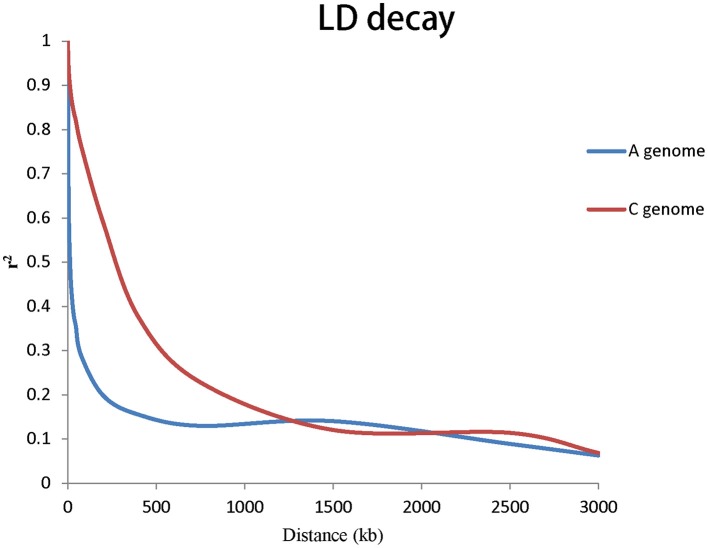
Genome-wide LD decay of A and C genomes for all the 143 accessions.